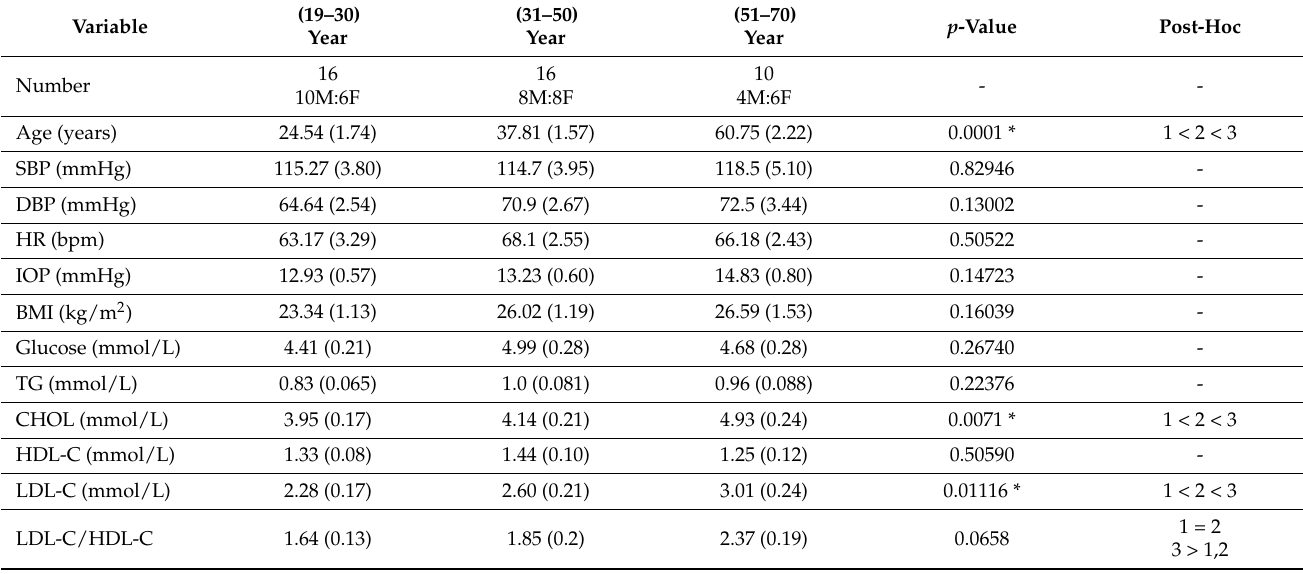
Table 1. Summary of the systemic characteristics of the study